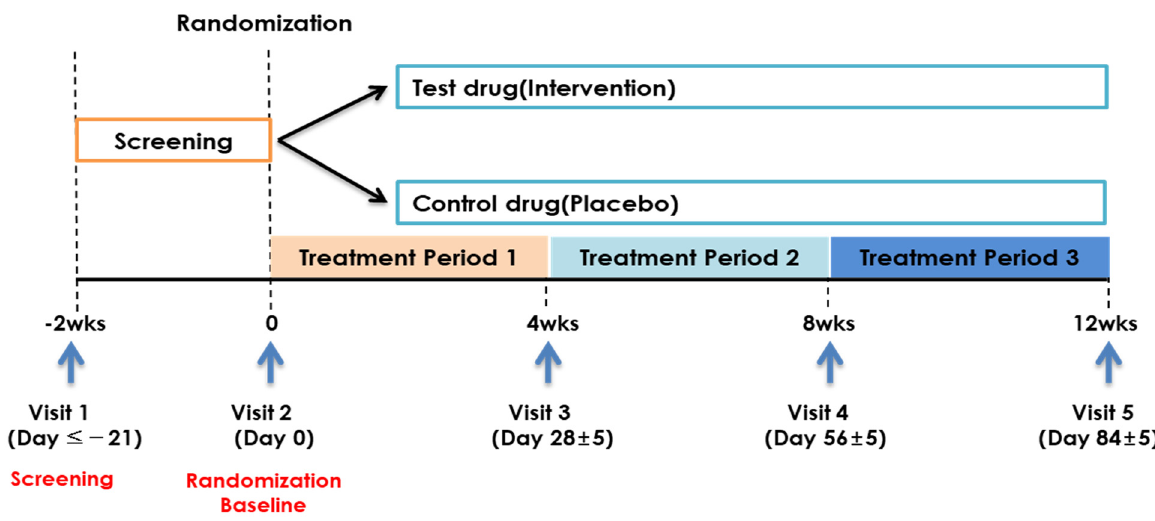
Figure 1. Clinical trial